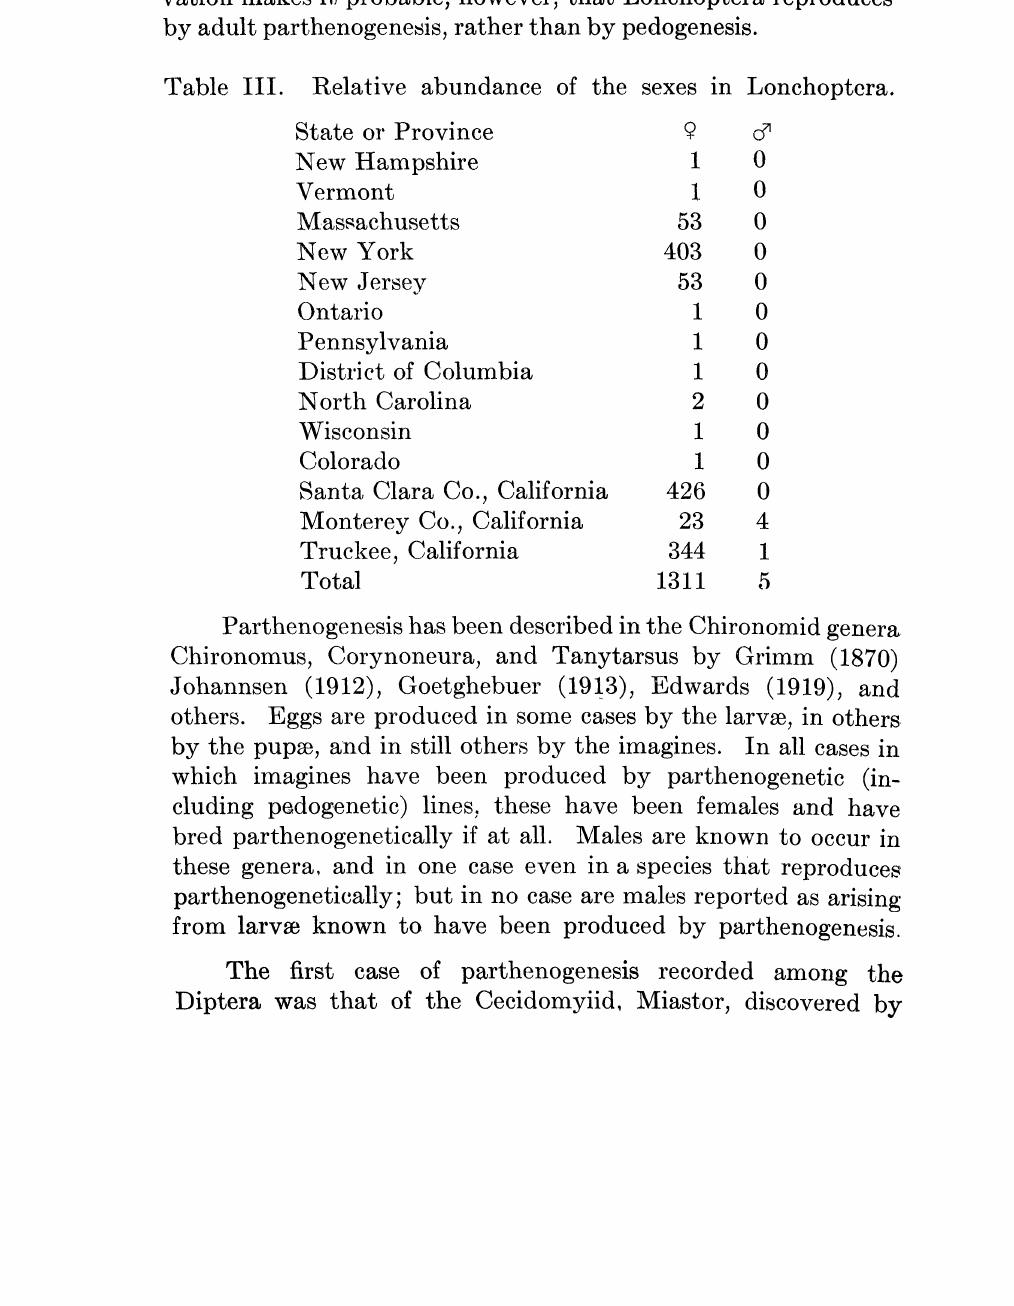
Relative abundance of the sexes in